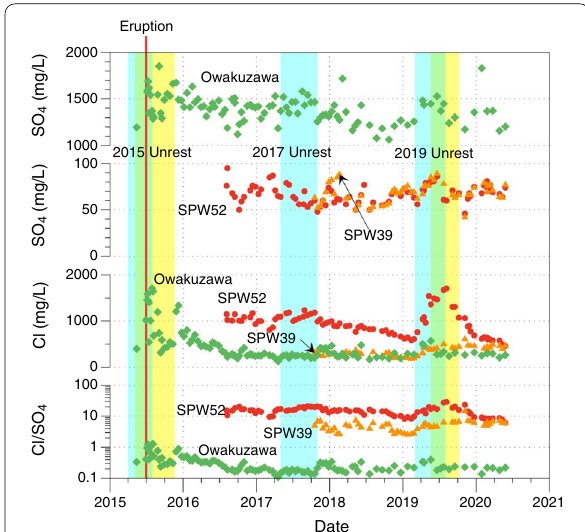
Fig. 10 Sequential changes in the chemistry of artificial hot springs created by the steam from SPW52 (red circle) and SPW39 (orange triangle), and water from the Owakuzawa river (green diamond)